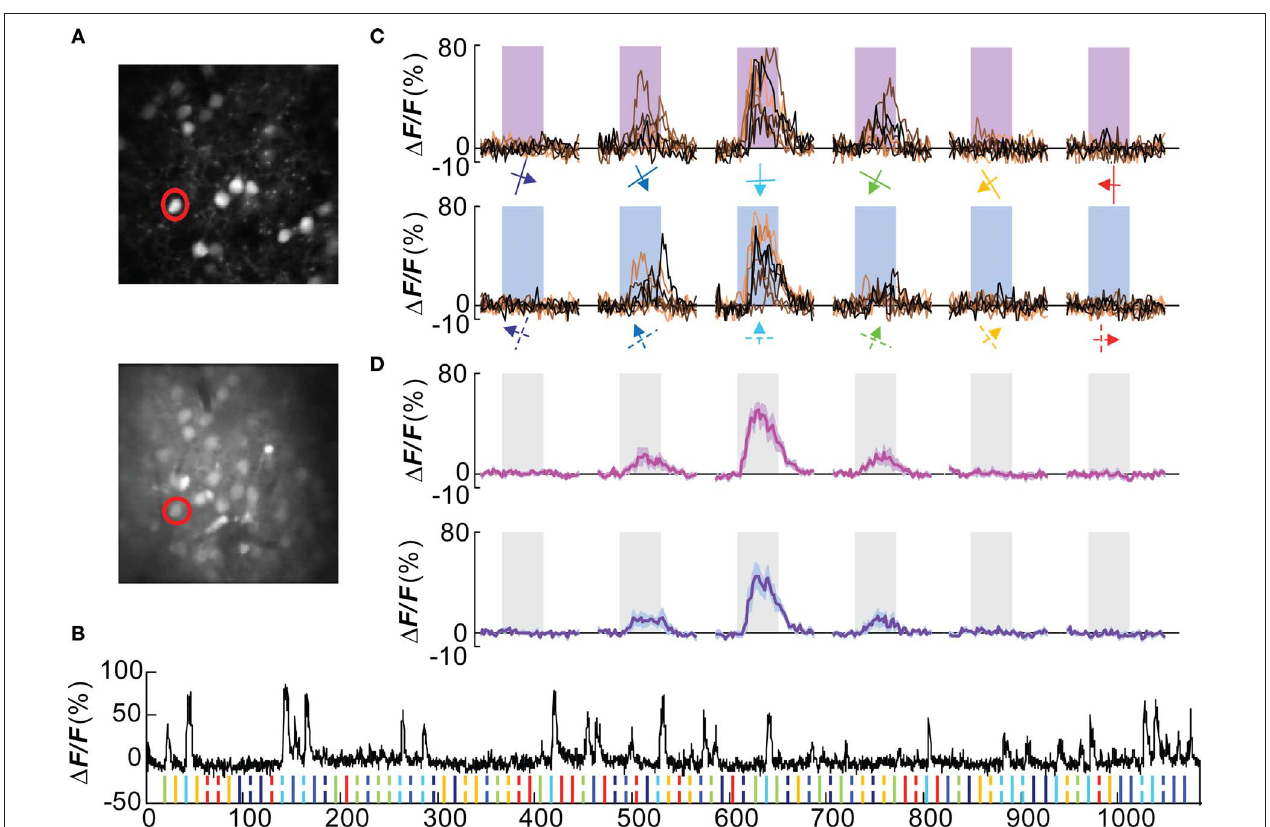
row]. (C) Plots in the upper row are change in fluorescence of the cell to eight presentations of six orientation gratings moving in one direction (shown by color coded arrows). Lower row is for corresponding opposite direction of motion (broken arrows). X -axis is time (in seconds). Shaded area represents time period of stimulus presentation. Stimulus was presented for 5 s. (D) Average of eight presentations in [ (C) upper row in magenta and lower row in purple]. Shaded area around the mean represents mean ± SEM ( n = 8